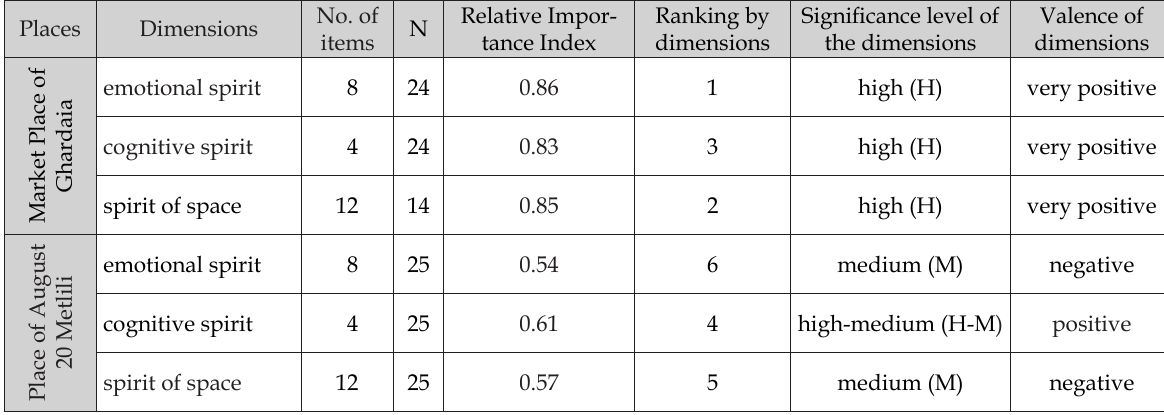
Table 6. Rank of spirits dimensions for public spaces.